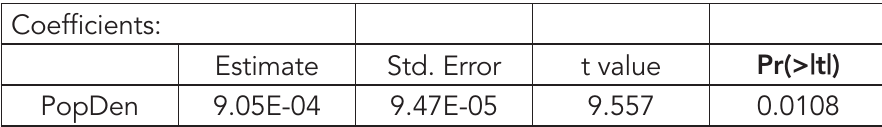
Table 5: Regression results for estimating policing cost through population density Coefficients: Estimate Std. Error t value Pr(>|t|)